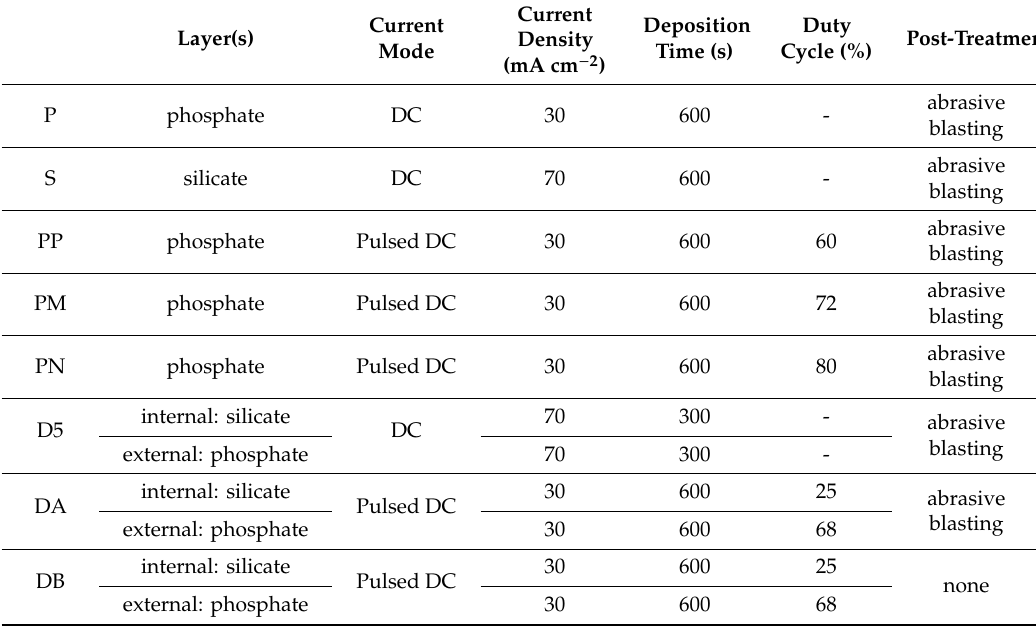
Table 1. Treatment conditions for the production of PEO